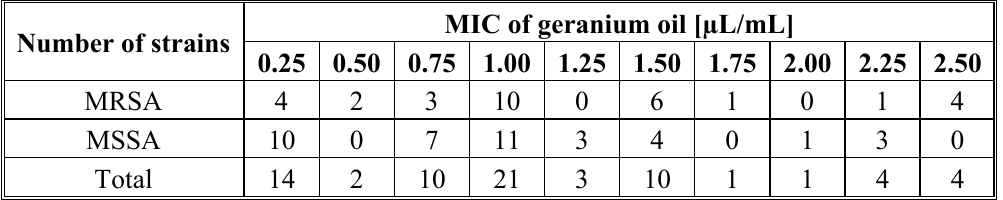
Table 9. Resistance to cefoxitin in correlation with MICs of geranium oil among S. aureus strains. Number of strains